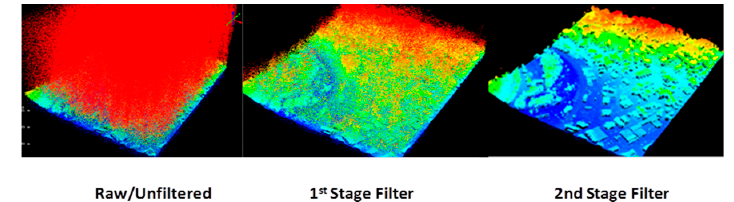
Figure 7. The automated filtering of HRQLS-1 lidar data taken on a single overflight of a residential community in Oakland, MD. The raw/unfiltered point cloud data is taken with a range gate of 4.6 microseconds corresponding to a total range interval of 690 m. The color scheme is deep blue to red in order of increasing elevation, and it should be mentioned that the solar noise is equally dense below the surface but does not show up as well in the raw unfiltered image because of the poor contrast against the black background. The first stage filter isolates a 90 m interval that contains the surface data as well as roughly 13% of the total noise, and the second stage filter uses narrower range bins (~5 m) to eliminate the vast majority of the remaining noise.